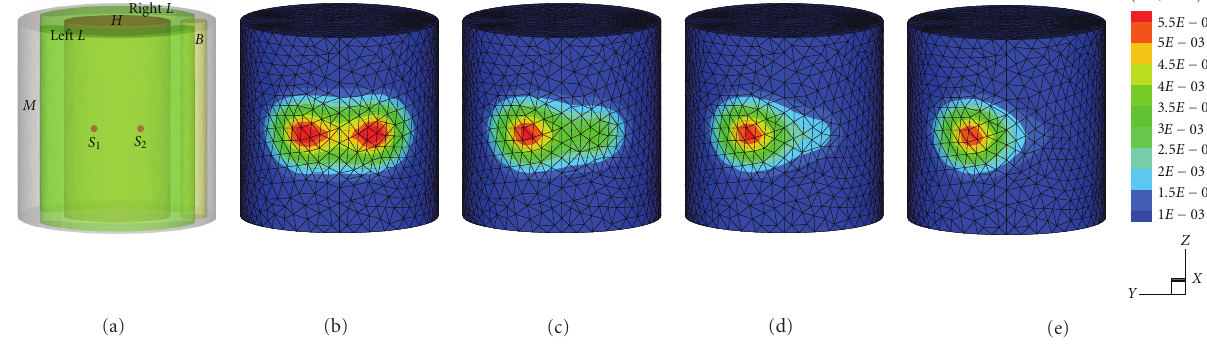
Figure 2: (a) 3D view of the heterogeneous phantom with two sphere sources in the left lung. (b)–(e) Di ff erent photon distributions generated, respectively, in power ratio of 1:1, 2 :1, 4 :1, and 8:1 cases. nonzero components. Consequently, the preprocessing of solution with a small threshold of c max ( S i ) is helpful to remove pseudosources and reduce the data size to be processed in the subsequent steps. For all the experiments in Section 3, the constant c = 0 . 05.